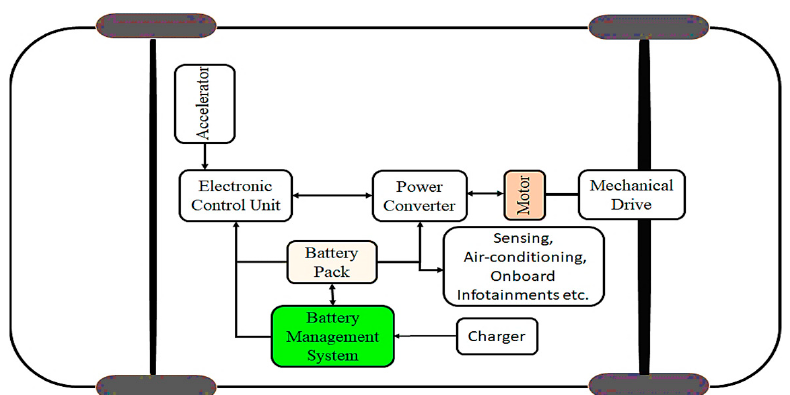
Figure 1. BMS operation inside the EV.